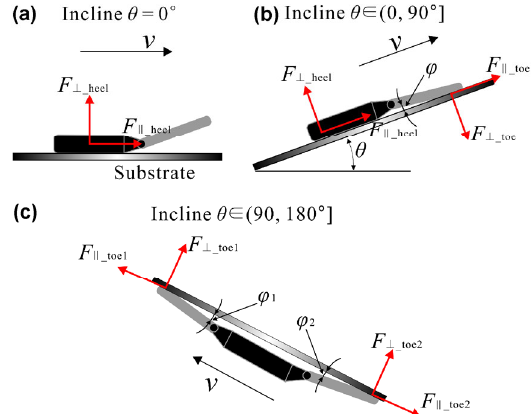
Fig. 5 The planar mechanical model of contact between foot and the inclined substrate. θ : incline of the substrate; v : locomotive direction. (a) A mechanical model of contact for 0° incline. Only the heel pushes away from the substrate to generate a supporting force ( F ) and friction force ( F ) on a level surface. (b) A ⊥ _heel ‖ _heel mechanical model of contact when incline does not exceed 90°. The state of contact is a concomitant contact of friction and adhesion. The toe pulls toward the substrate to generate adhesive friction force ( F ) and adhesion force ( F ), while the heel ‖ _toe ⊥ _toe pushes away the substrate. φ : angle between the toe and the substrate. (c) A mechanical model of contact when the incline exceeds 90°. More toes adhere to the substrate to generate adhesion and friction forces, whereas the heel does not make contact with the substrate. F and F : the adhesion forces acting on toe1 and toe2; ⊥ _toe1 ⊥ _toe2 F and F : the adhesive friction forces acting on toe1 and ⊥ _heel1 ⊥ _heel2 toe2; φ 1 and φ 2 : the angles between the toe1/2 and the substrate.